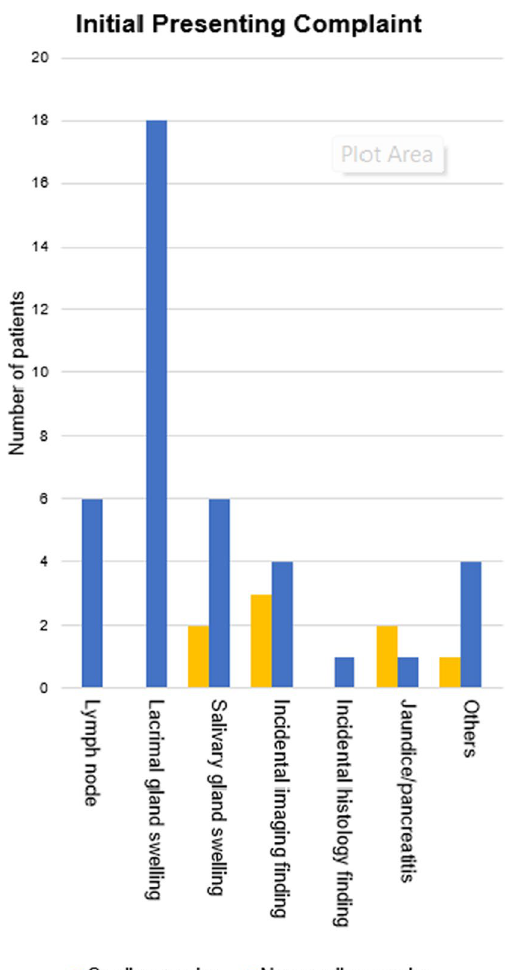
Fig. 1 Initial presenting complaints of all patients diagnosed with IgG4‑related disease. The most common presentation in all patients with IgG4‑related disease was lacrimal gland or orbital gland swelling, followed by salivary gland swelling. Two patients presented with both lacrimal and salivary gland